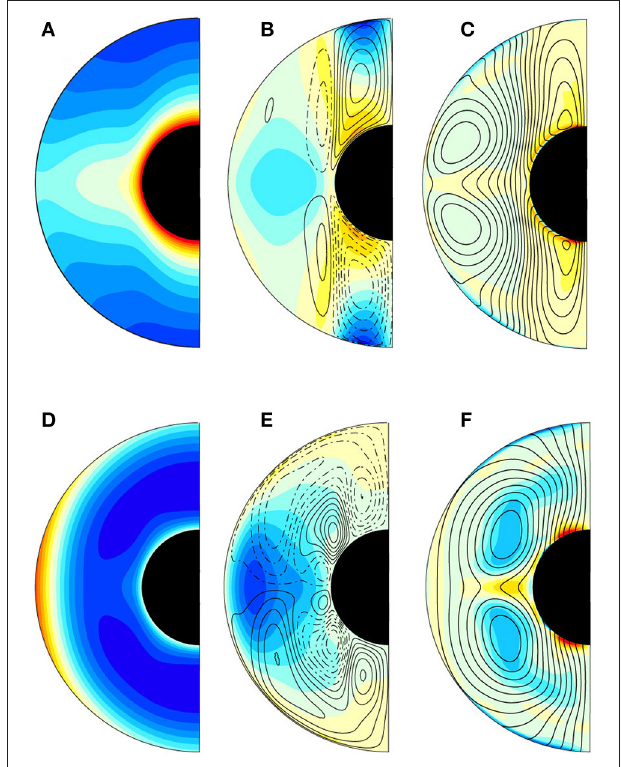
FIGURE 3 | Zonal average numerical dynamo structures at Ra two stratification parameters: S show codensity contours; images (B,E) show meridional circulation streamlines (clockwise=dashed; counterclockwise=solid) over azimuthal velocity contours; images (C,F) show poloidal magnetic field lines over azimuthal electric current contours, all dimensionless. Red contours=positive, blue=negative.